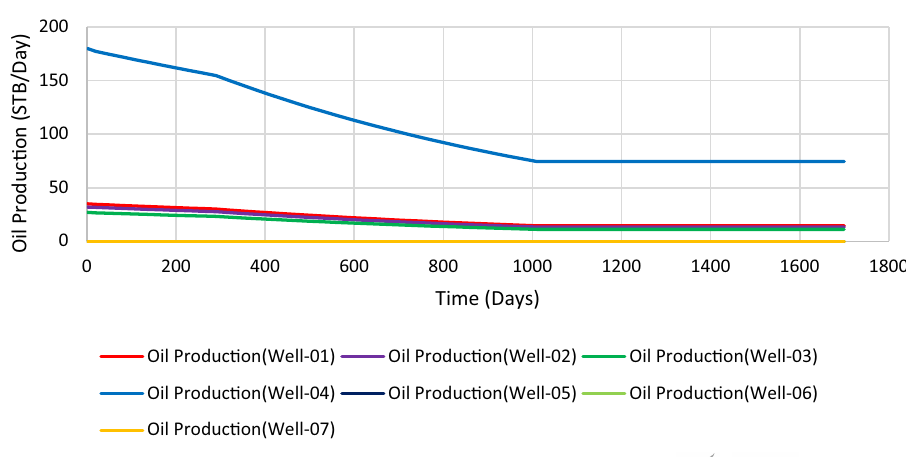
Fig. 5 Oil production rate for each